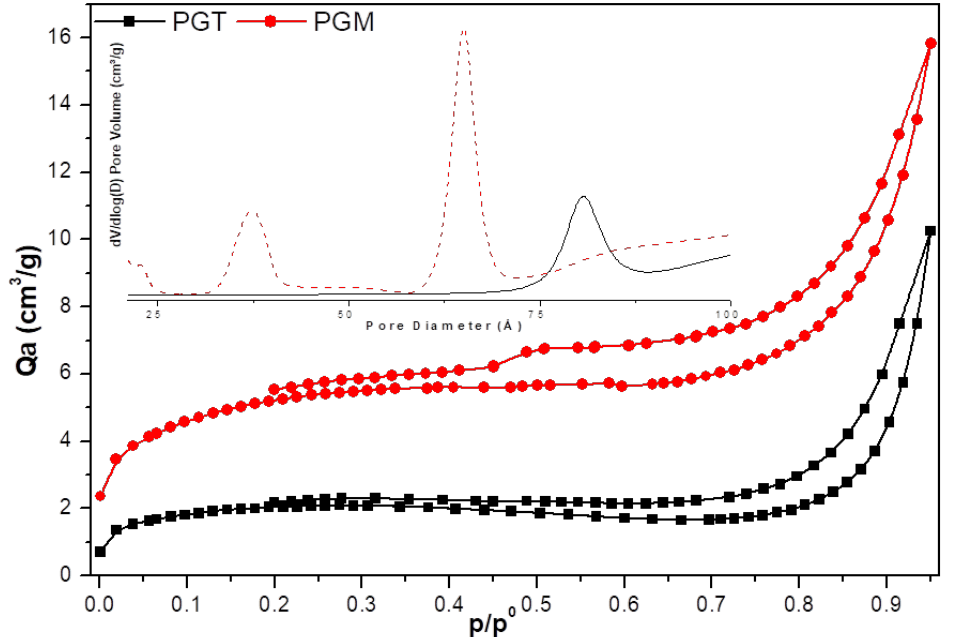
Figure 5. Nitrogen adsorption/desorption isotherms and the pore distribution of the PGT and PGM samples.